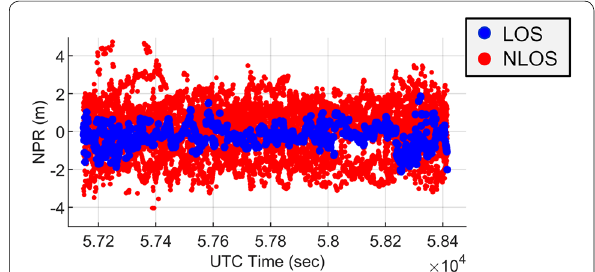
Fig. 5 Demonstration of NPR of LOS and NLOS in an urban test